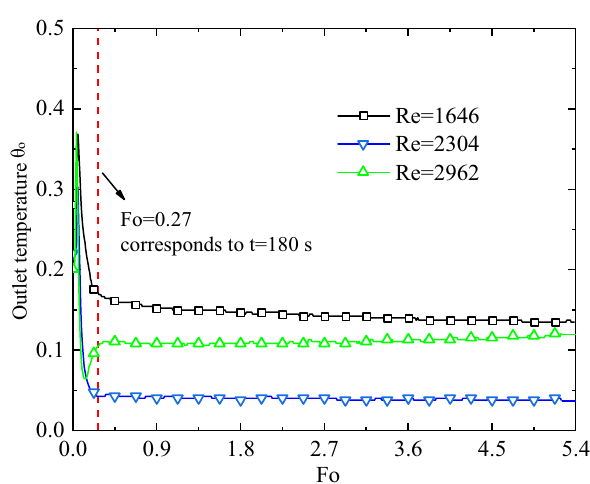
Fig. 6 Variation of outlet water temperature with time in forward flow mode